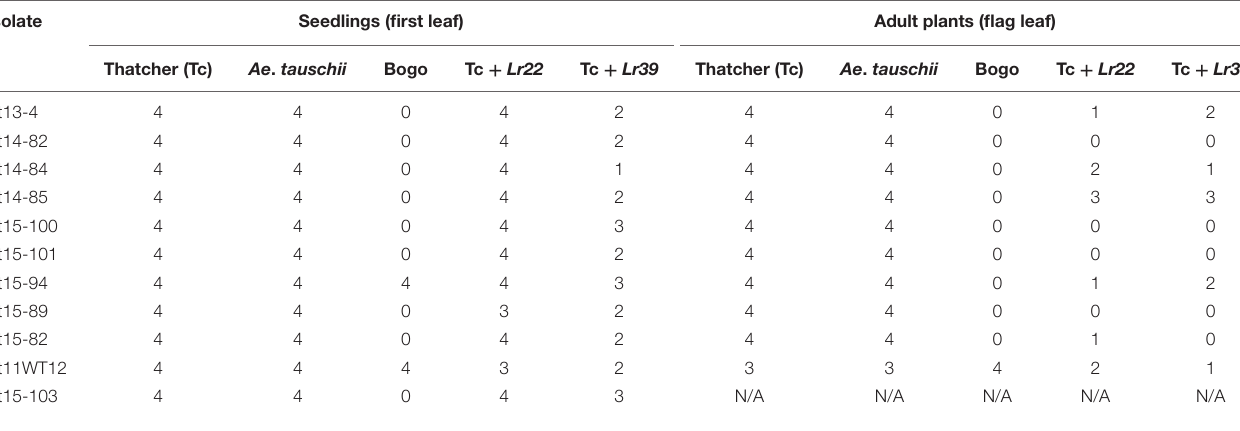
TABLE 1 | Reaction of plant genotypes (scale 0–4, description in “Materials and Methods” section) at seedling and adult plant stage to inoculation with 11 isolates of P . triticina . Isolate Seedlings (first leaf) Adult plants (flag